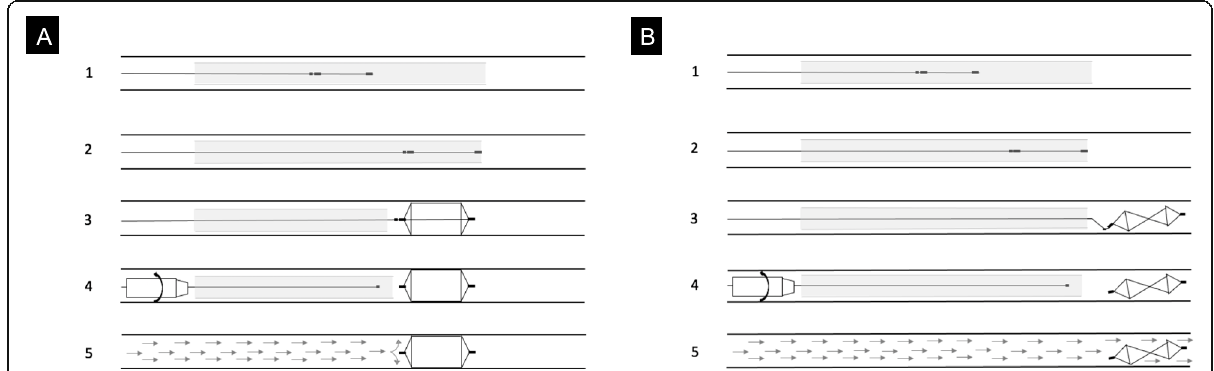
Fig. 1 Schematic drawing of MVP release technique. In A , the correct pull-back technique is reported; in step 1 MVP is positioned into the catheter (proximal and distal radiopaque markers are indicated by long black segments while the radiopaque detachment point by short black segment); in step 2 MVP is advanced up to the tip of the catheter; in step 3 the catheter is moved backward in order that MVP is completely expanded outside the catheter; in step 4 MVP is detached with mechanical torqueing; in step 5 MVP properly occludes the vessel lumen with the blood flaw being interrupted. In B , the wrong pushing technique is reported; in steps 1 and 2, as in A, MVP is positioned into the catheter and advanced up to the tip of the catheter; in step 3 MVP is pushed forward outside from the catheter, with its nitinol skeleton kinked and crushed not properly expanded; in step 4 MVP is detached with mechanical torqueing; in step 5 MVP is wrongly released not interrupting the blood flow into the vessel lumen